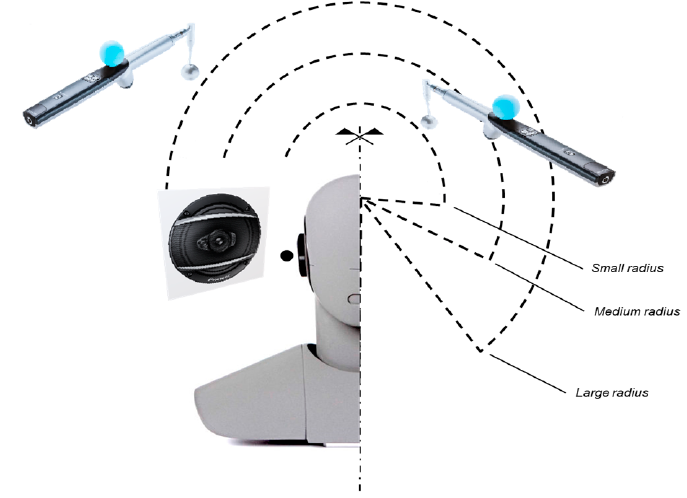
Figure 6. Schematic representation of the concentric spherical surfaces around the binaural head, scanned with the Soundbrush probe.